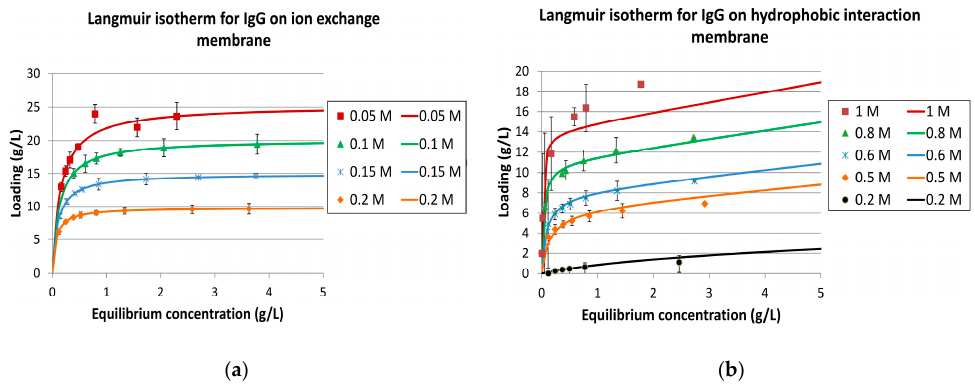
Figure 8. Langmuir isotherms for immunoglobulins (IgG) on ion-exchange membrane (IEX) ( a ) and hydrophobic interaction membrane (HIC) ( b ).